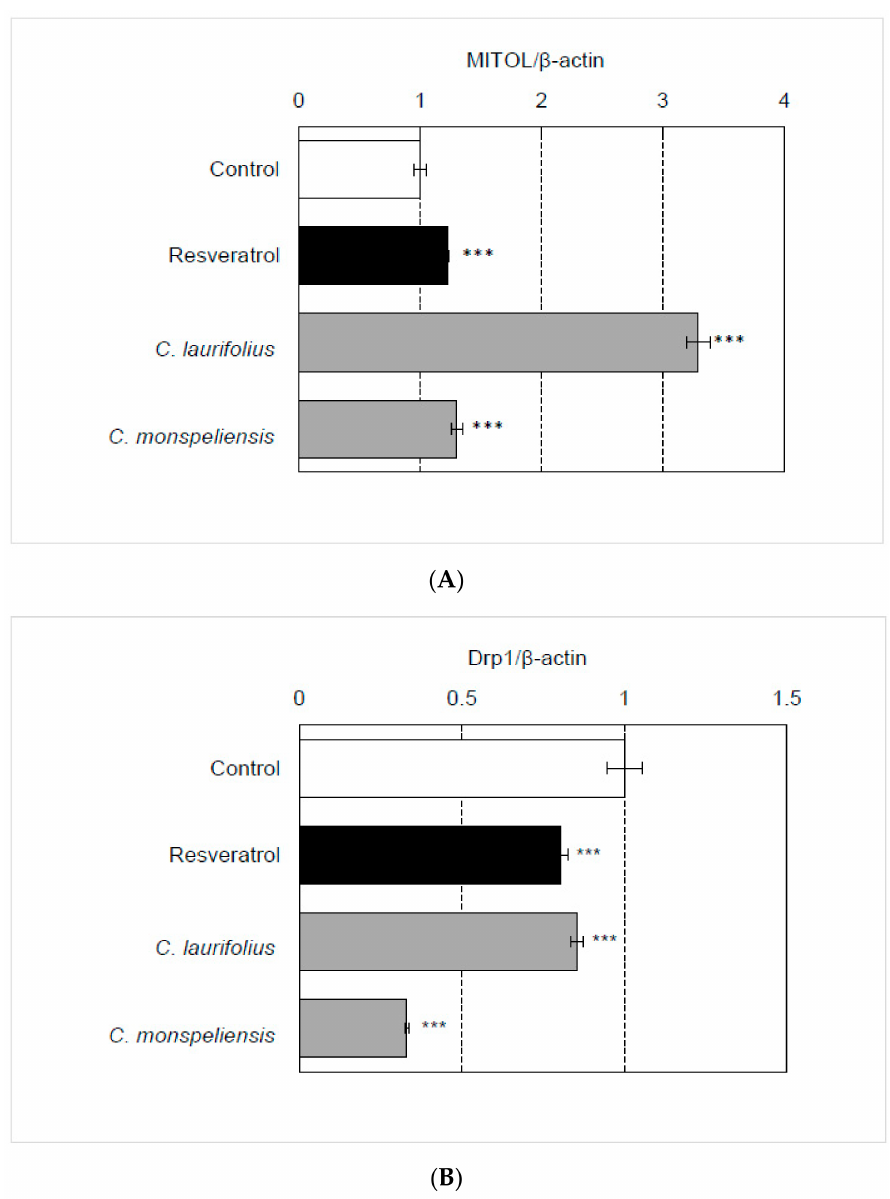
Figure 4. Effects of essential oils on the gene expression involved in the regulation of mitochondrial morphology. The effects of essential oils (final concentration: 100 ng/mL) on the expression of MITOL ( A ) and Drp1 ( B ) in HaCaT cells were evaluated by qRT-PCR. Statistical significance was determined by using a two-sided Student’s t -test. Statistical significance was evaluated by comparison with the control and defined as p < 0.05 (*** p < 0.001). Values are means ± SEM ( n = 3). As a control treatment, HaCaT cells were treated with